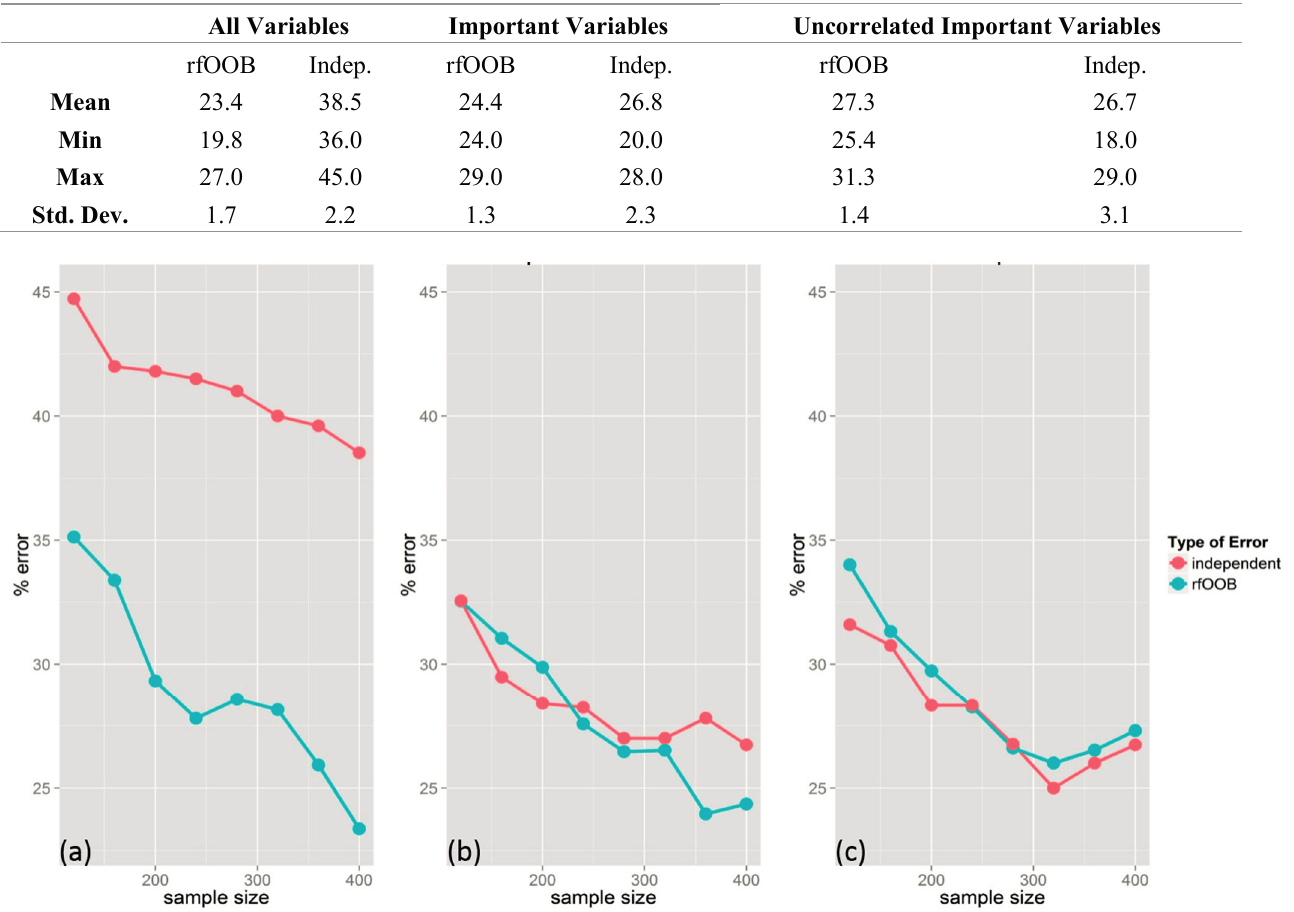
Table 4. Mean, Minimum (min), Maximum (max) and standard deviation (Std. Dev.) of rfOOB error and independent assessment error (Indep.) for 25 iterations of each of three classifications.